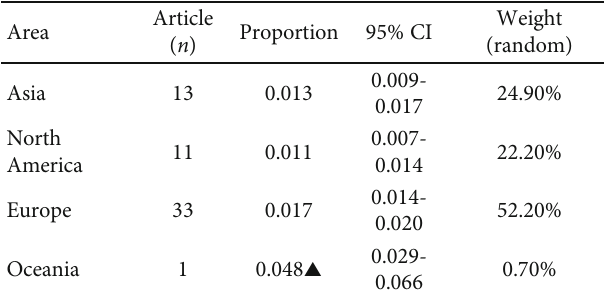
Table 5: Geographic variation risk of CRC in UC